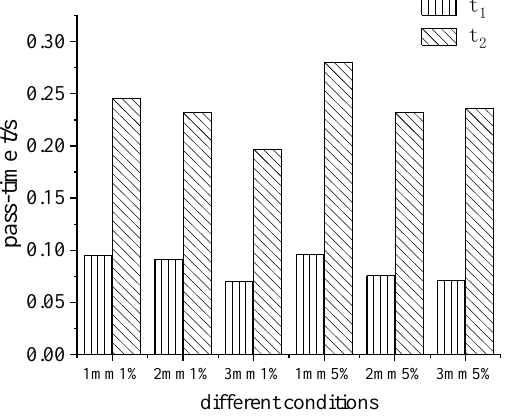
ff erent valves of particle diameter and Figure 10. Particle movement time with different valves of particle diameter and concentration. Figure 10. Particle movement time with di